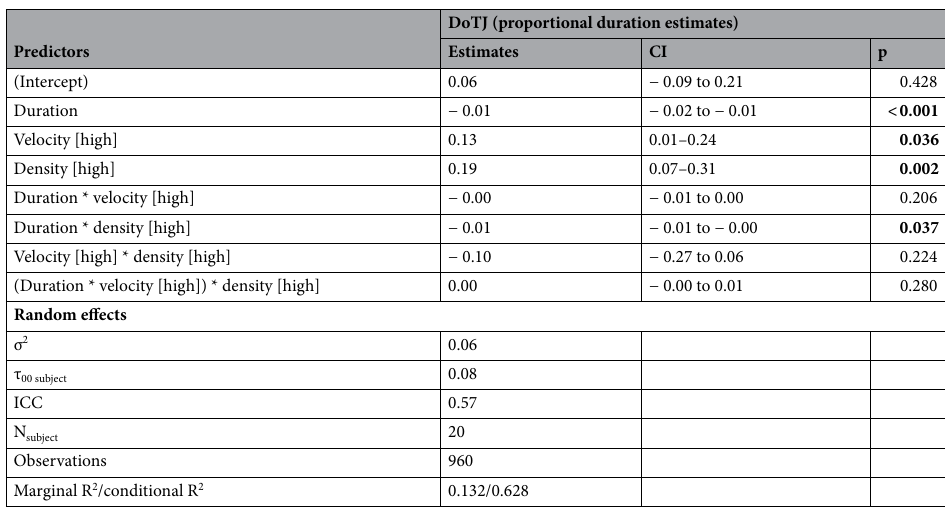
Table 1. Summary of the linear mixed effects model for DoTJs (proportional duration estimates), including predictors (as fixed effects) for Duration, Velocity, Density, and all potential interactions. Estimates (in s) and their confidence intervals as well as p-values of the individual predictors can be found in the first part of the table. The intercept refers to a (fictional) condition combination of Duration = 0, Velocity = low, Density = low. The estimates of the other predictors can be interpreted as the expected change in DoTJs in case of a corresponding change in the condition. To account for the repeated measures design, participant wise differences were modeled as random intercept for participants. The second part of the table informs about the random effects (mean variance, ‘σ2’; between subject variance, ‘τ00 subject’, intraclass correlation ICC) as well as some general characteristics of the model (N, Observations, R 2 ). Significant values are given in bold.